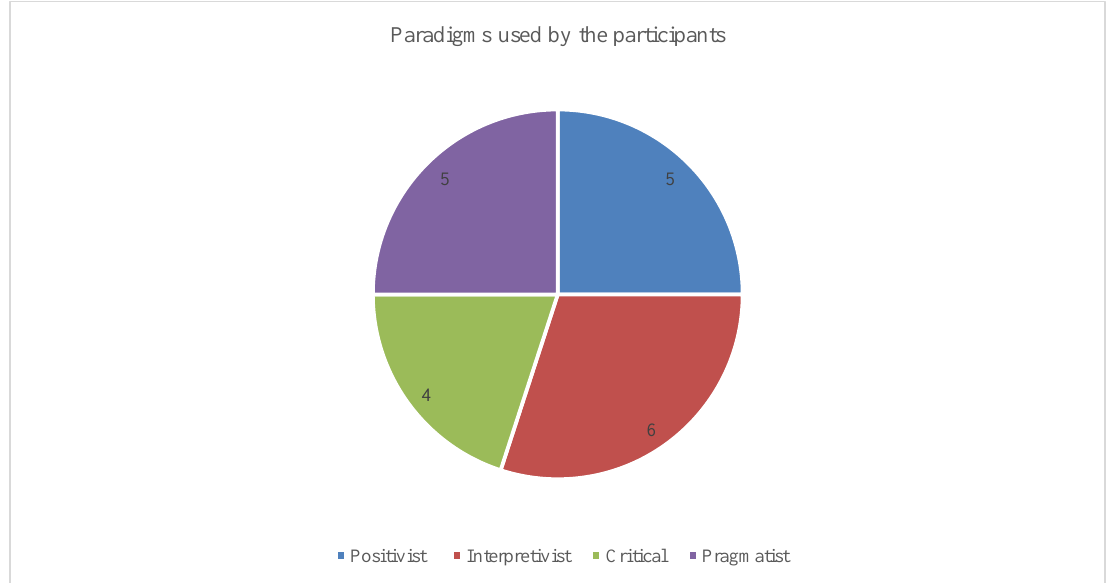
Figure 5: Research paradigms used by the